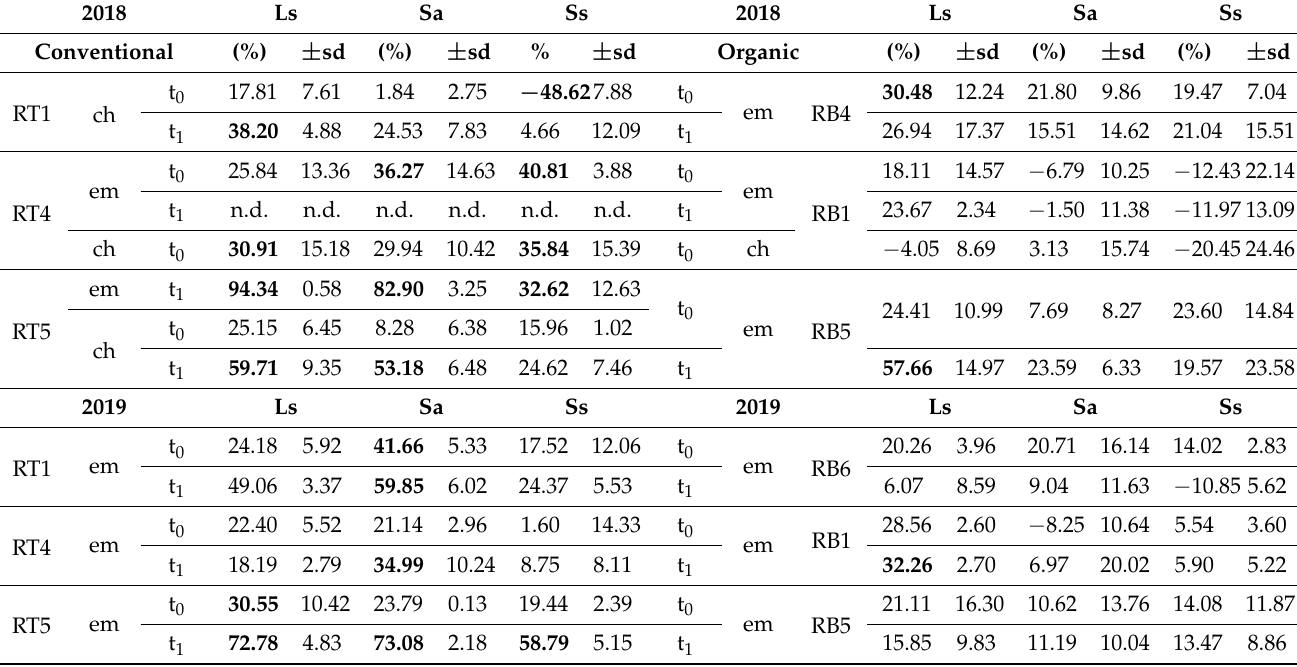
Table 4. Results of phytotoxicity tests with Lepidium sativum (Ls), Sinapis alba (Sa), Sorghum saccharatum (Ss) on samples of soil collected during campaigns t 0 and t 1 (in bold are shown the significative effects above the toxicity threshold). Negative sign indicates biostimulation of root growth in comparison to control (Ch = rise chamber; em = embankment).